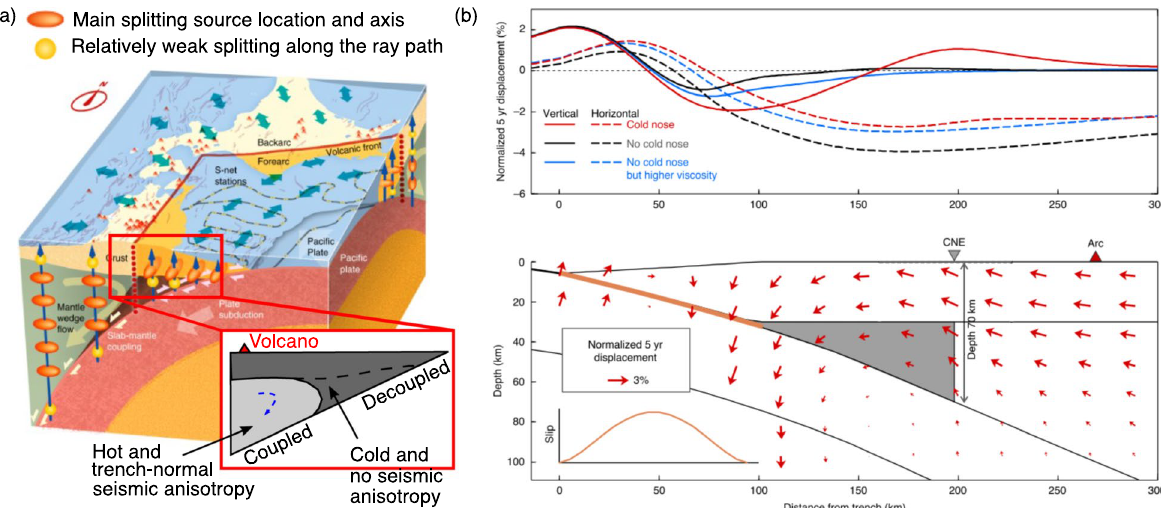
Fig. 14 a Seismic anisotropy and thermal contrast in the forearc mantle (after Uchida et al. 2020). b The effect of cold nose in the surface deformation during 5 years of postseismic period (after Luo and Wang